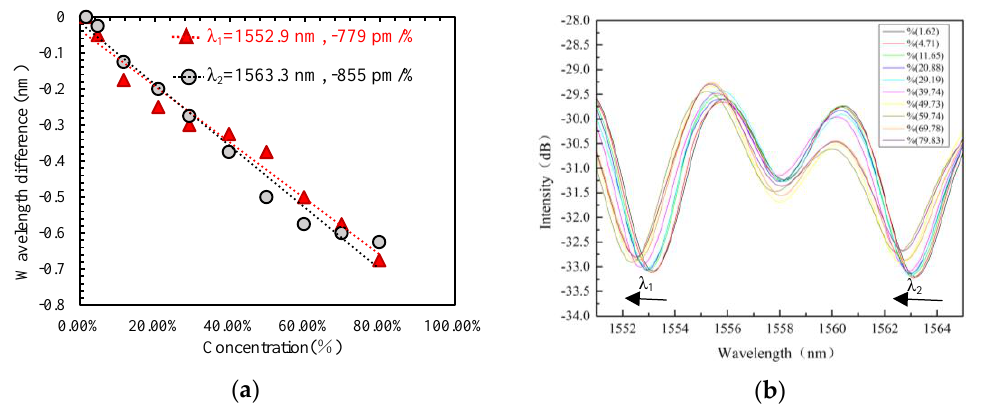
Figure 5. ( a ) Linear fittings of two different wavelengths shift with alcohol gas concentration. ( b ) Superposition spectrum of the sensor at different alcohol gas concentrations.